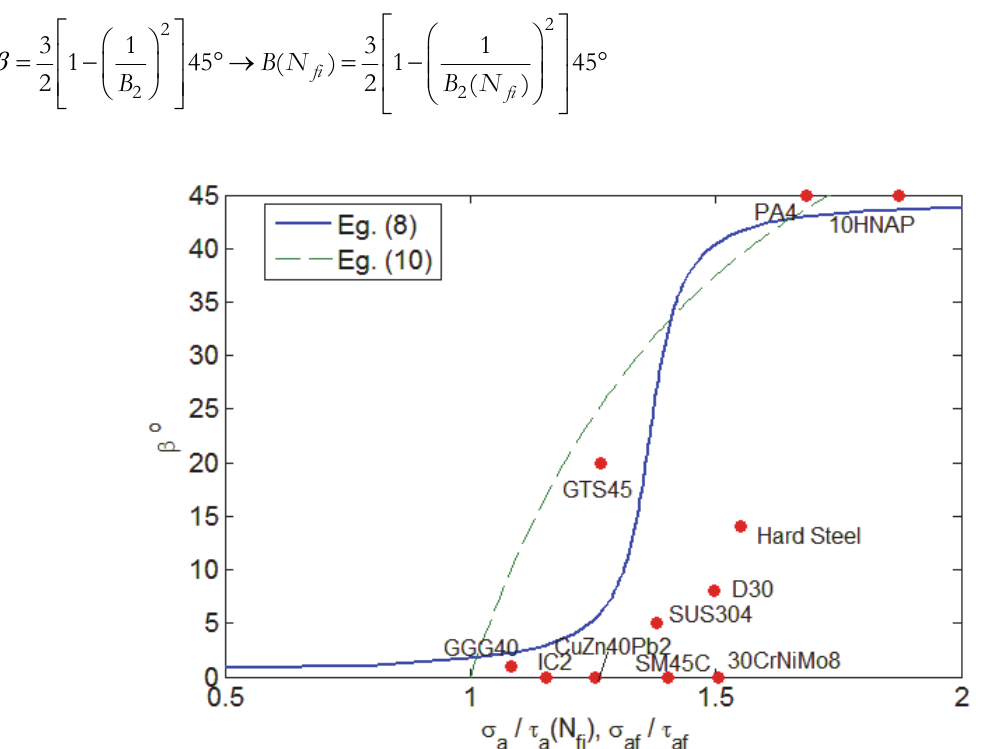
Figure 1: The relationship between the angle β and the parameter B 2 according to different